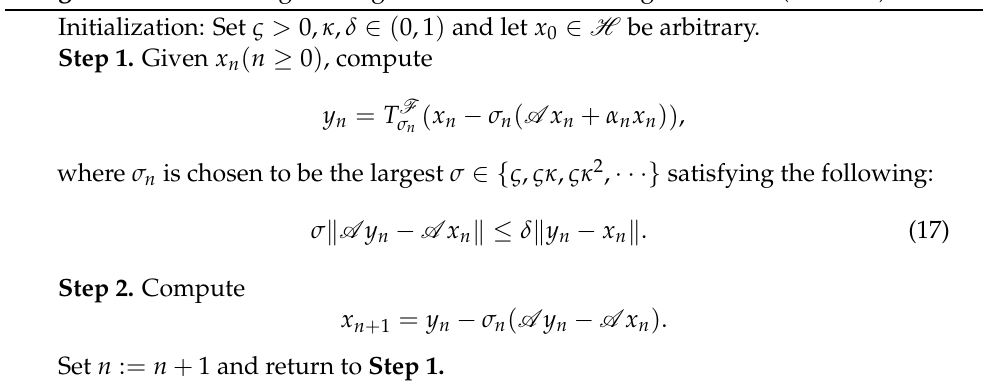
Algorithm 3: The Tseng’s extragradient method with regularization